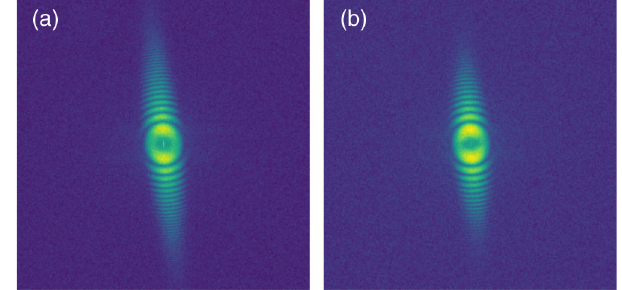
FIG. 8. Acquired raw data (a) and corresponding differential heterodyne speckles resulting from the DFA (b). Notice that the speckle pattern is remarkably uniform, despite the intensity modulations and stray-light contributions clearly visible in the raw image. The side of each square image is roughly 260 μ m in real space. Data refer to κ ¼ 0 . 50% and z ¼ 1 . 1 m.